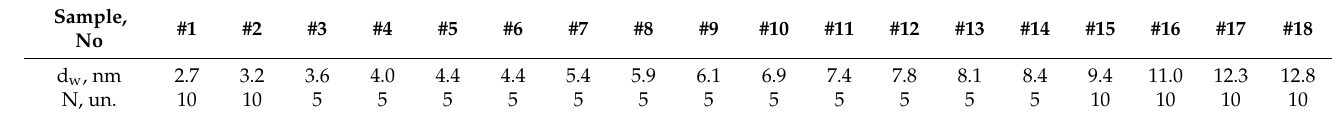
Table 1. The Hg 0.38 Cd 0.62 Te/Hg 1-y Cd y Te well width under the growth and